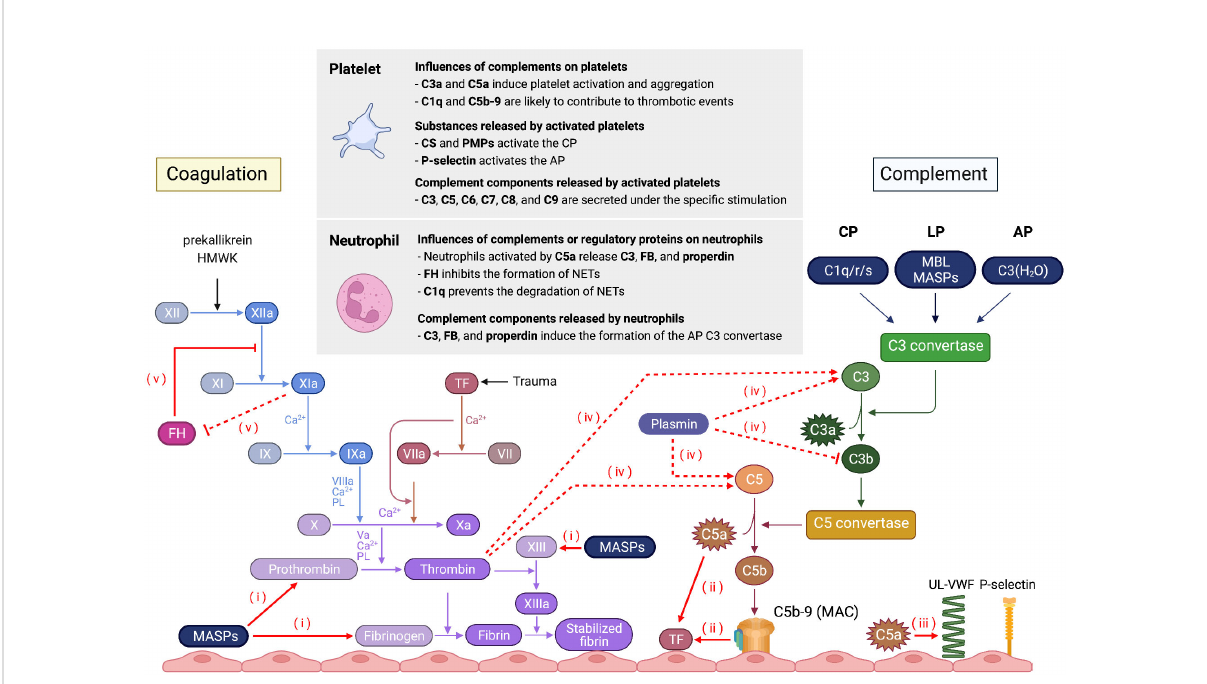
FIGURE 2 Schematic overview of the interaction between the complement system and the coagulation system, platelets, and neutrophils. (i) MASPs can cleave coagulation factors, such as prothrombin, fi brinogen, and factor XIII. (ii) C5a and C5b-9 enhance blood thrombogenicity through upregulation of TF in endothelial cells and neutrophils. (iii) C5a induces UL-VWF secretion and P-selectin expression. Conversely, coagulation factors activate the complement cascade. (iv) Thrombin and plasmin can generate C3a and C5a, whereas plasminogen enhances FI-mediated C3b cleavage in the presence of FH and plasmin degrades C3b. (v) Factor XIa decreases the cofactor and decay acceleration activity of FH and the ability binding of FH to bind to human endothelial cells. Conversely, FH inhibits FXIa